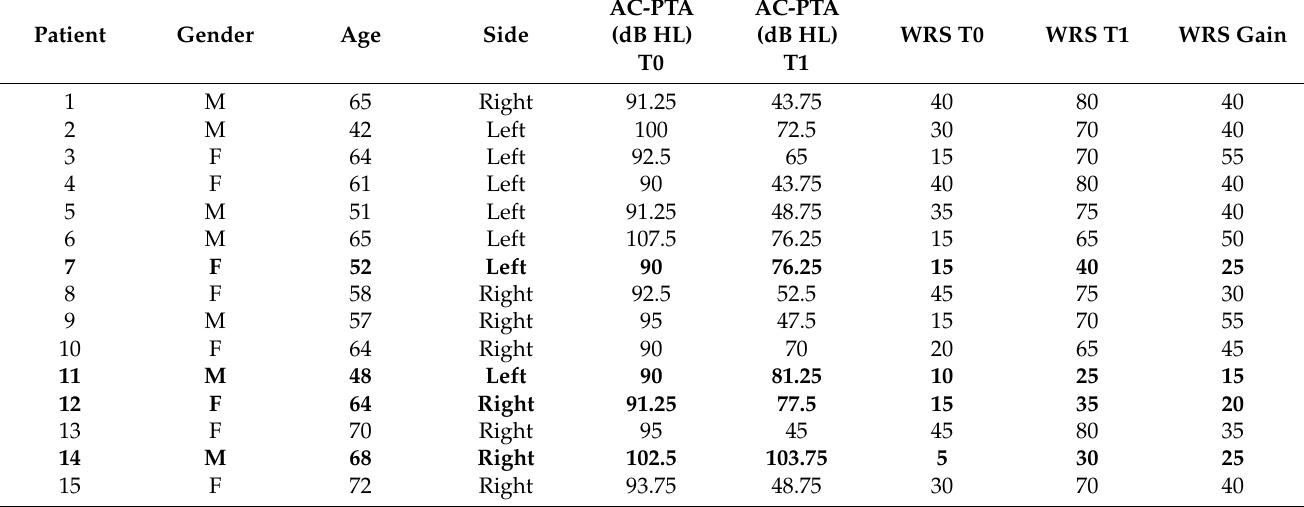
Table 1. Characteristics of our sample and details of auditory and speech understanding values before and after surgery. Bolded rows represent patients who needed cochlear implants due to unsatisfactory recovery of auditory functions when combining stapedectomy and hearing aids.